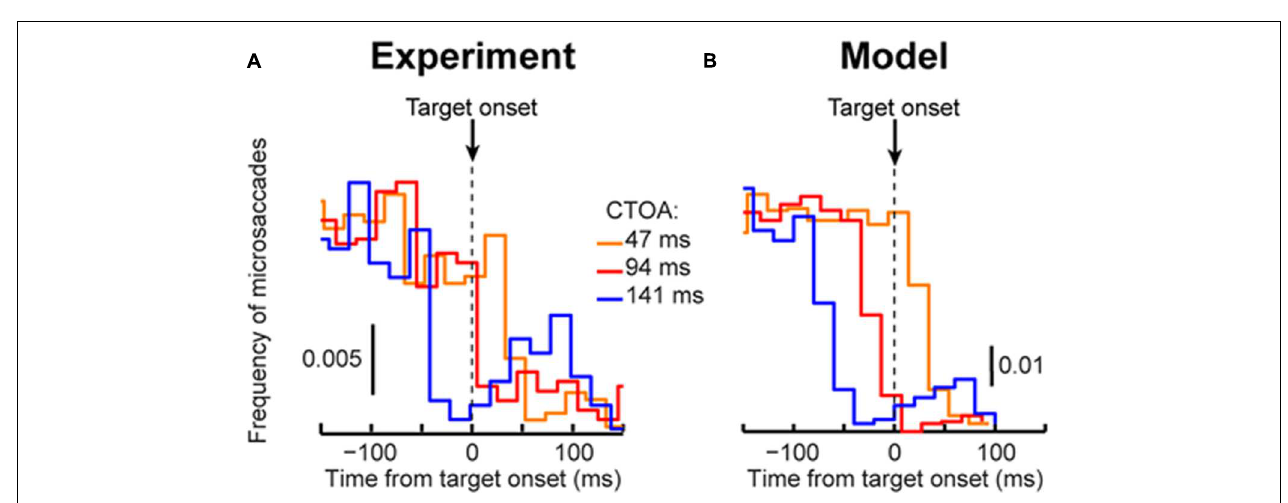
FIGURE 6 | Our model can account for cueing dynamics even if microsaccades are rare. (A) Microsaccade frequency around target onset for the shortest three CTOA’s in “same” trials. Virtually identical curves were obtained from “opposite” trials. Each curve shows data from > 2,000 trials. The timing between target and cue onset caused modulations in microsaccade frequency as a function of CTOA. For example, there were extremely few microsaccades near target onset in 94 ms CTOA trials even though RT in these trials was markedly different from RT in other CTOA’s (see Figure 3 ). (B) Model microsaccades showed similar modulations (see Figure 4 for other CTOA’s). In this case, we ran the model for 2,000 trials per CTOA. Thus, the model captured large changes in RT across CTOA ( Figure 3 ) even when microsaccades around target onset were rare. The rarity and rebound were a function of the resetting of microsaccadic rhythms (Hafed and Ignashchenkova, 2013). Importantly, microsaccade sparseness did not prevent replicating individual subject data (see Figure 7